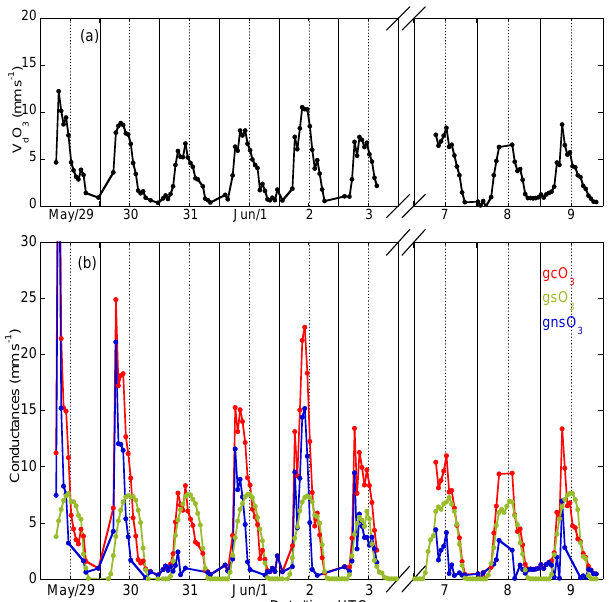
Figure 7. Diel variations in (a) ozone deposition velocity ( V d O 3 ) , (b) canopy conductance ( g c O 3 ) , stomatal conductance ( g s O 3 ) , and non-stomatal conductance ( g ns O 3 ) from 29 May to 9 June in 2012. The partitioning was obtained with the Lamaud et al. (2009) ap- proach (see text for